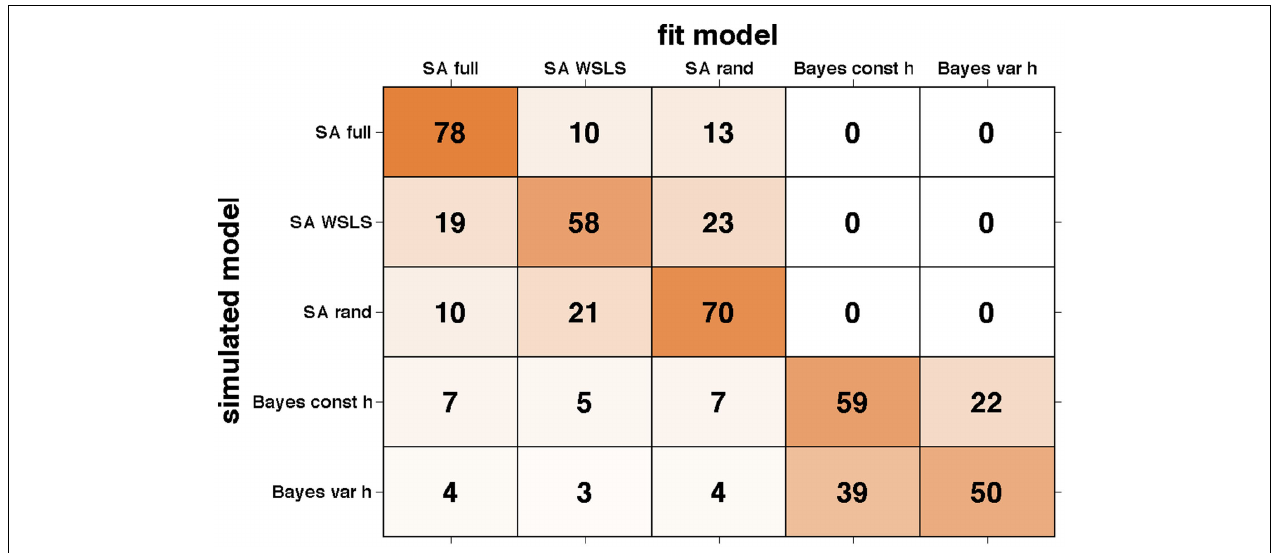
FIGURE 9 | Confusion matrix showing the percentage of times data generated by the model on the y -axis was fit by the model on the x -axis. Shading corresponds to the numbers such that darker represents higher numbers.